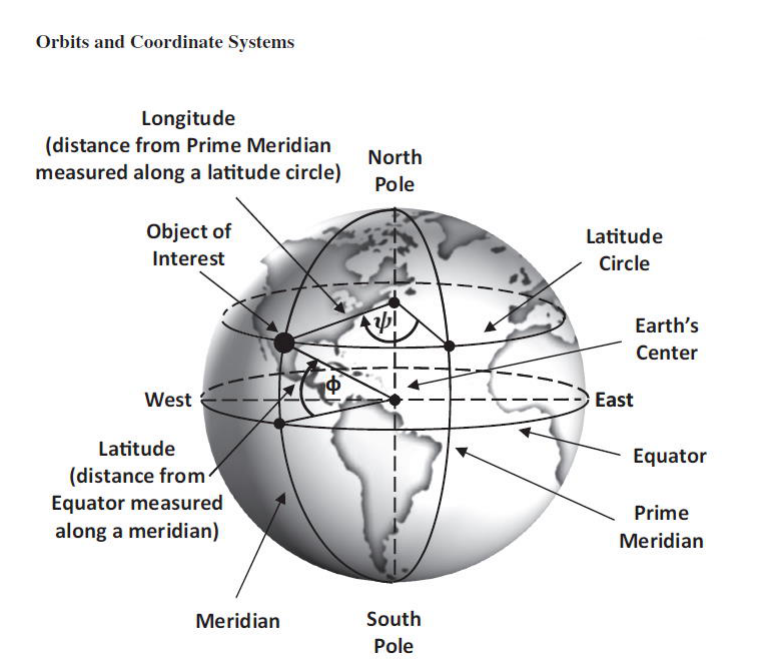
Figure 1. Geodetic (spherical) coordinate system. Reprinted/adapted with permission from [5], 2019,